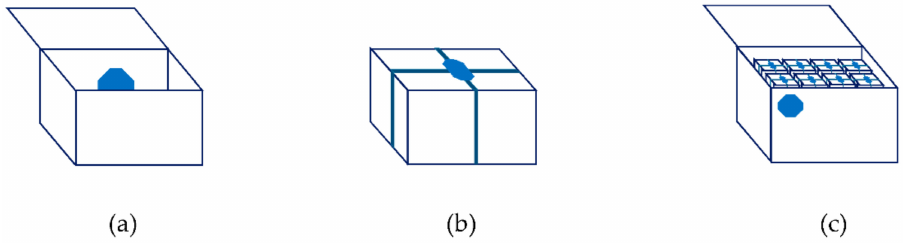
Figure 3. Device usage—topologies. ( a ) Type A device placed inside. ( b ) Type B device placed outside. ( c ) Star network with type B device operating as central (one of the Bluetooth Low Energy (BLE) roles) and placed outside the container and type A or B devices operating as peripherals (another BLE role) placed together with the